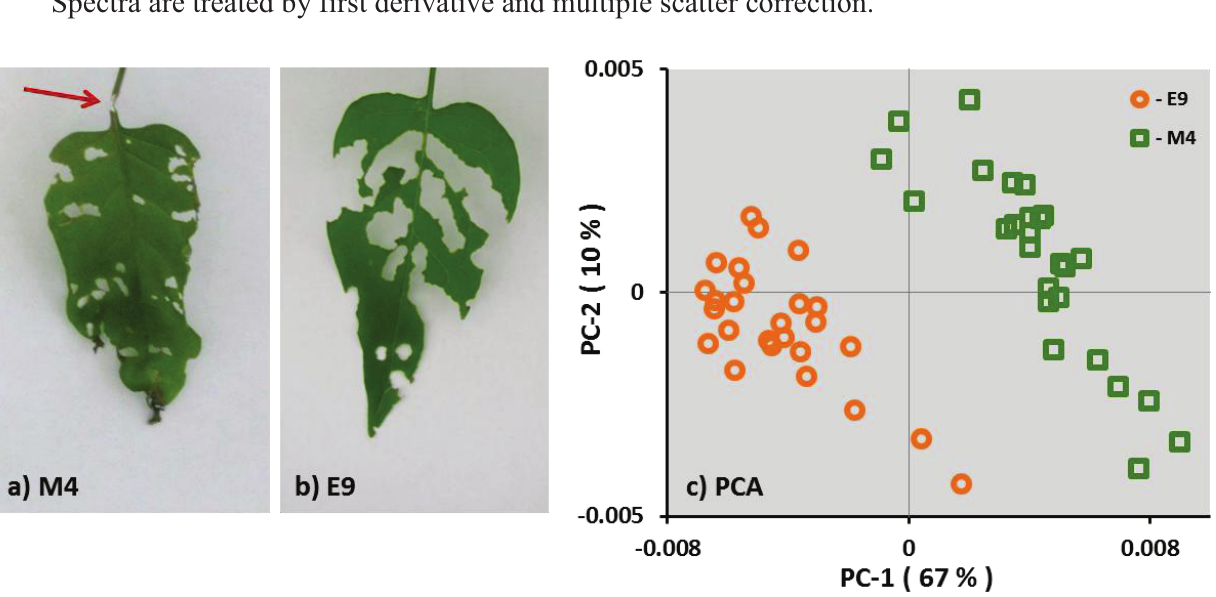
Figure 1. Feeding pattern of S. exigua larvae on the leaves of genotype M4 ( a ) and E9 ( b ). The arrow shows a petiole chewed by the larvae in a M4 leaf. Principle component analysis (PCA) of the FT-IR spectra ( c ) of M4 and E9 over the spectral range of 360 – 375 cm − 1 . Spectra are treated by first derivative and multiple scatter correction.